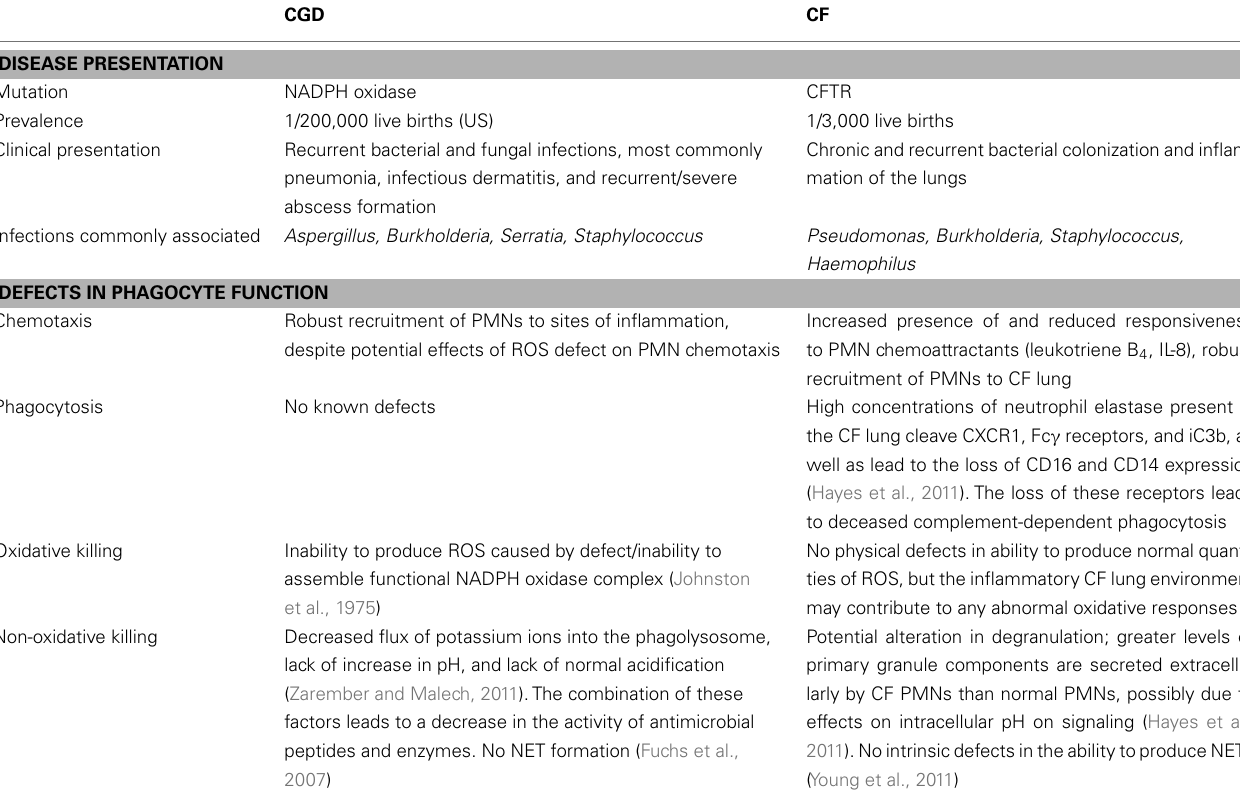
Table 1 | Comparison of disease presentation and phagocyte function in CGD and